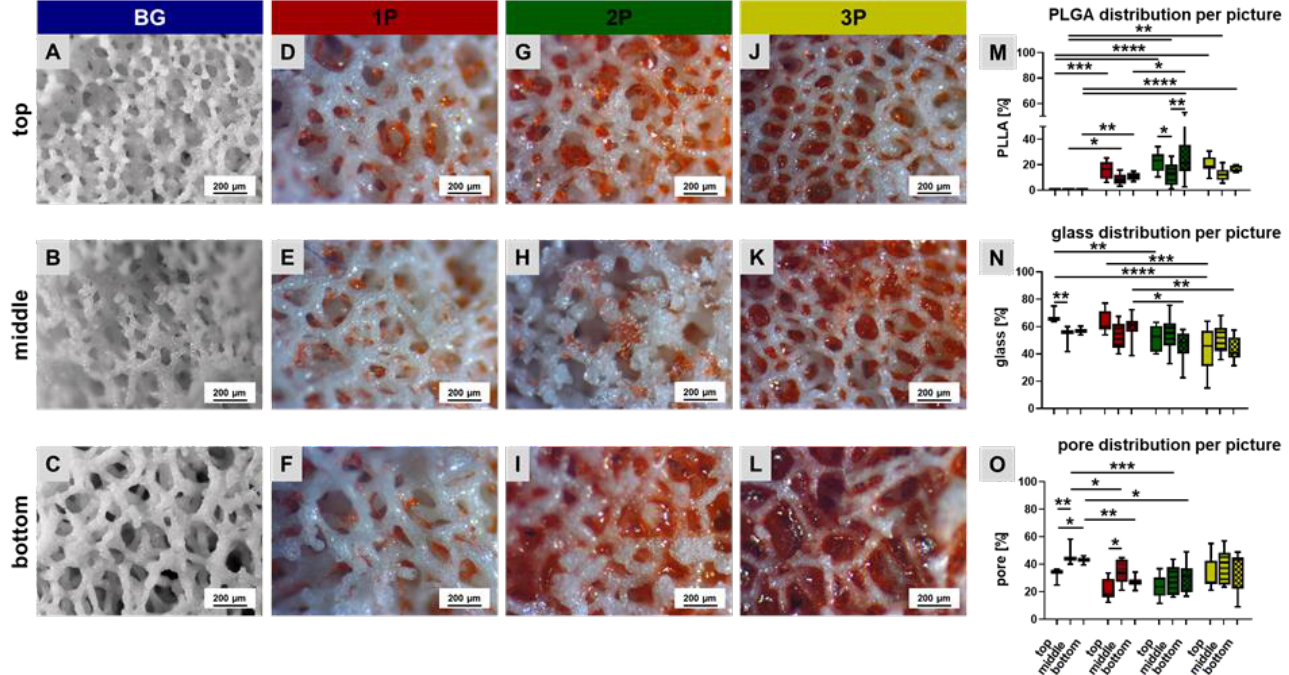
Figure 2. Detailed view of the four scaffold variants. The scaffolds (BG = pure bioactive glass scaffold ( A – C ) in blue ( M – O ), 1P = single ( D – F ) in red ( M – O ), 2P = twofold ( G – I ) in green ( M – O ) and 3P = threefold PLGA infiltrations ( J – L ) in yellow ( M – O )), were vertically cut and light microscopic images were taken from the top view ( A , D , G , J ), from the middle ( B , E , H , K ) and the bottom ( C , F , I , L ) view. The percentage distribution of PLGA ( M ), of glass ( N ) and pores ( O ) per picture was calculated. n = 4. Ordinary two-way ANOVA with multiple comparison, p values: * p < 0.05, (**) for p < 0.01; (***) for p < 0.001 and with (****) for p < 0.0001. Scale bar: 200 µm, PLGA was red dyed with the dye Sudan IV red.